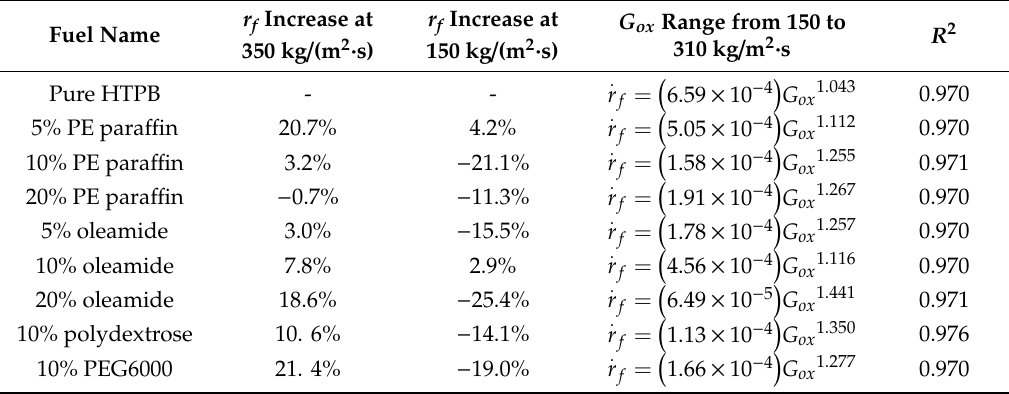
Table 3. r f increase and fitting results of r f / G ox curves for polymer particles / HTPB composite fuels.